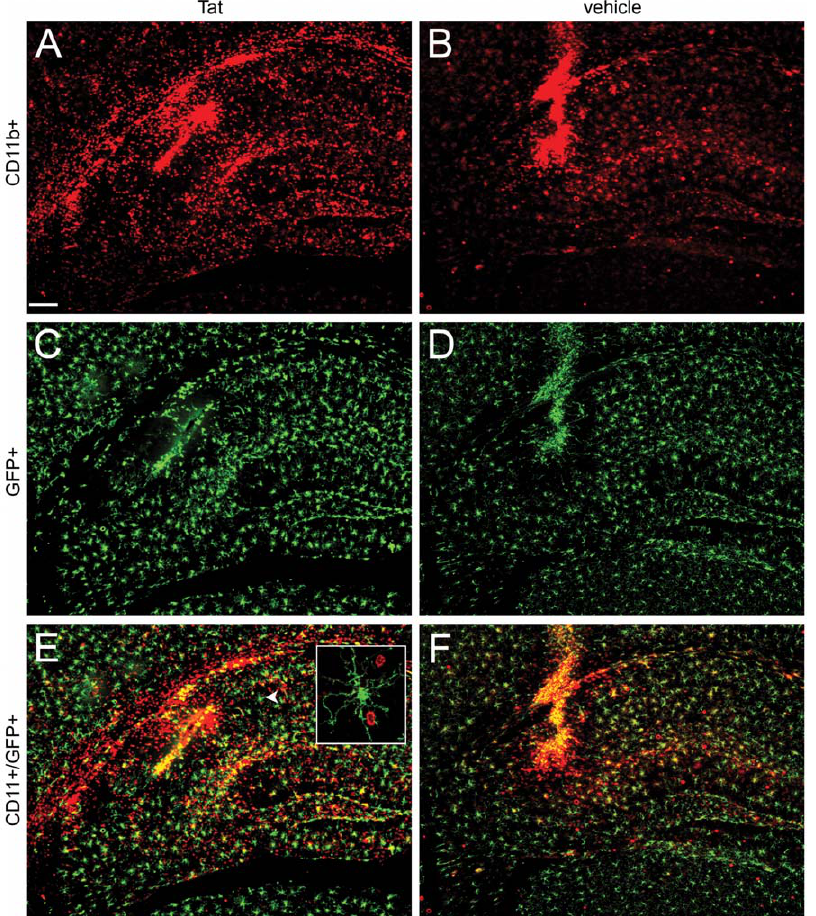
Figure 3. Stereotactic injection of Tat into hippocampus does not induce amoeboid microglial morphology in irradiation chimera. Montage of micrographs 24 hours after Tat (Panels A, C, and E) or control vehicle (Panels B, D, and F) injection into right hippocampus in CX 3 CR1/ GFP + / 2 hosts engrafted with congenic CD45.1 bone marrow. A and B show CD11b + cells (red), C and D show GFP + microglia (green) present in the same section, and E and F presents an overlay of the two images - highlighting the CD11b + /GFP + co-expressing cells (orange) as well as the single positive cells. The inset in panel E shows a ramified GFP + microglial cell (white arrowhead) in higher magnification and the 2 infiltrating CD11b + peripheral leukocytes (red). All experimental and control groups, n=3 independent replicates. Scale bar shown in Panel A=100 m m for all figures.